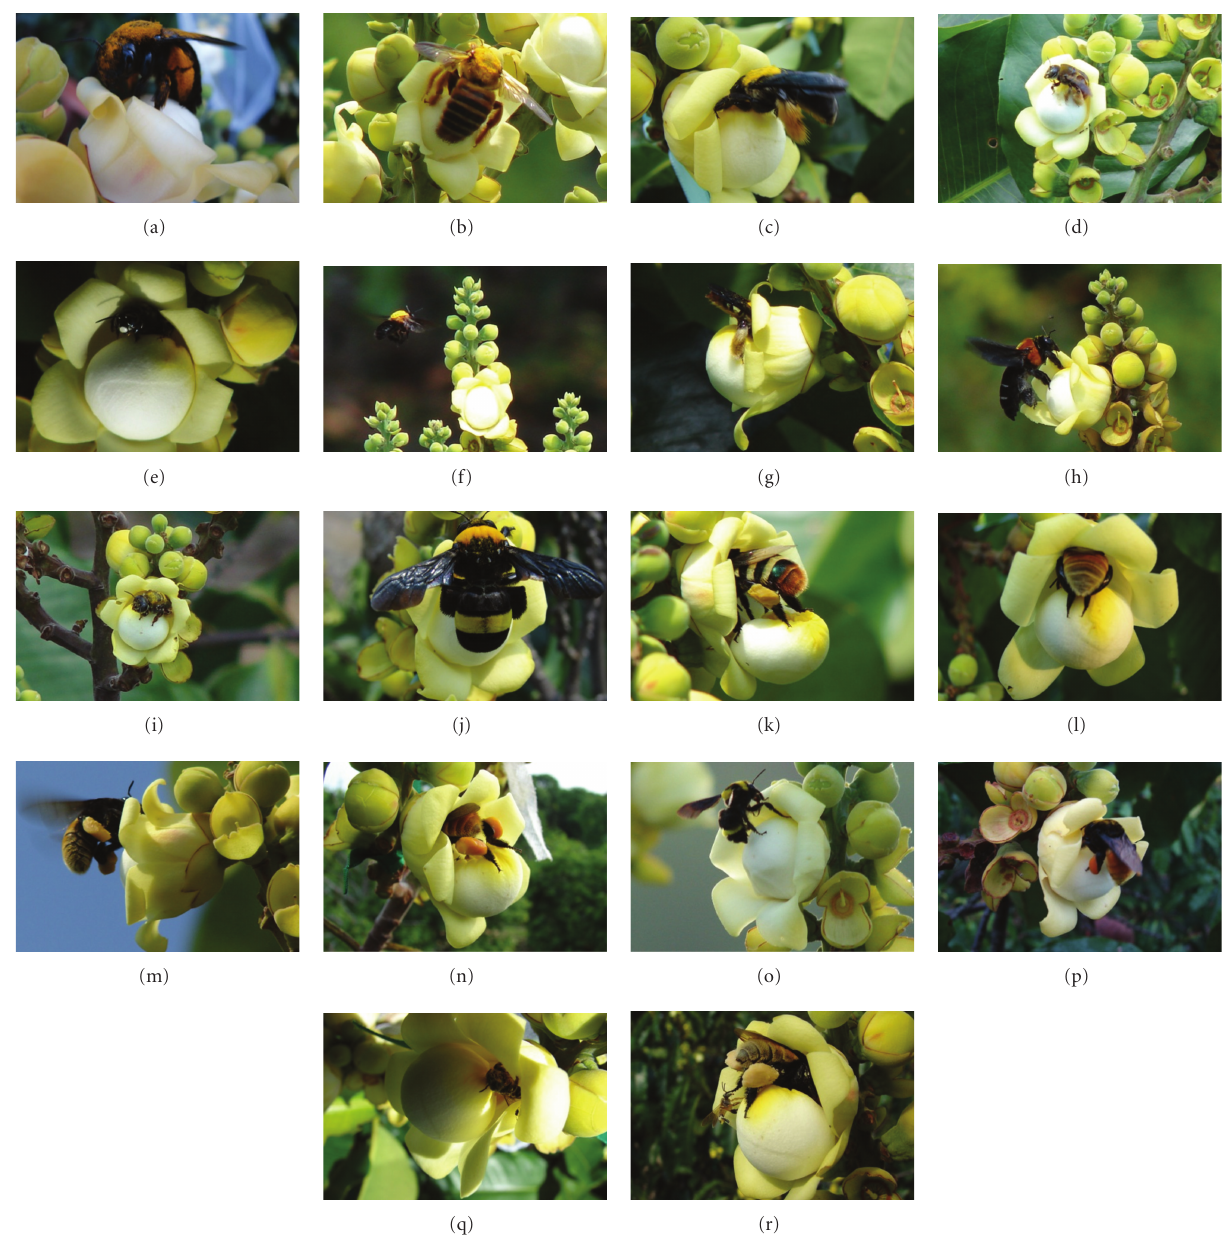
Figure 2: Approach to flowers of Brazil nut ( Bertholletia excelsa ) by distinct bee species in a commercial cultivation in the county of Itacoatiara, state of Amazonas, Brazil, 2007. ((a); (b)) Xylocopa frontalis ( ♀ and ♂ , resp.); (c) Epicharis (Epicharana) flava ( ♀ ); ((d); (e)) Epicharis (Epicharana) conica ( ♀ and ♂ , resp.); (f) Epicharis (Epicharis) umbraculata ( ♀ ); (g) Epicharis (Parepicharis) zonata ( ♀ ); (h) Centris (Ptilotopus) denudans ( ♀ ); (i) Centris ferruginea ( ♀ ); (j) Centris (Ptilotopus) americana ( ♀ ); (k) Eulaema (Eulaema) meriana ( ♀ ); ((l); (m)) Eulaema ( Apeulaema ) mocsaryi ( ♂ and ♀ , resp.); (n) Eulaema ( Apeulaema ) cingulata ( ♀ ); (o) Bombus ( Fervidobombus ) transversalis ( ♀ ); (p) Eufriesea flaviventris ( ♀ ); (q) Megachile sp.1; (r) Frieseomelitta longipes robbing pollen from El. (A.) mocsaryi